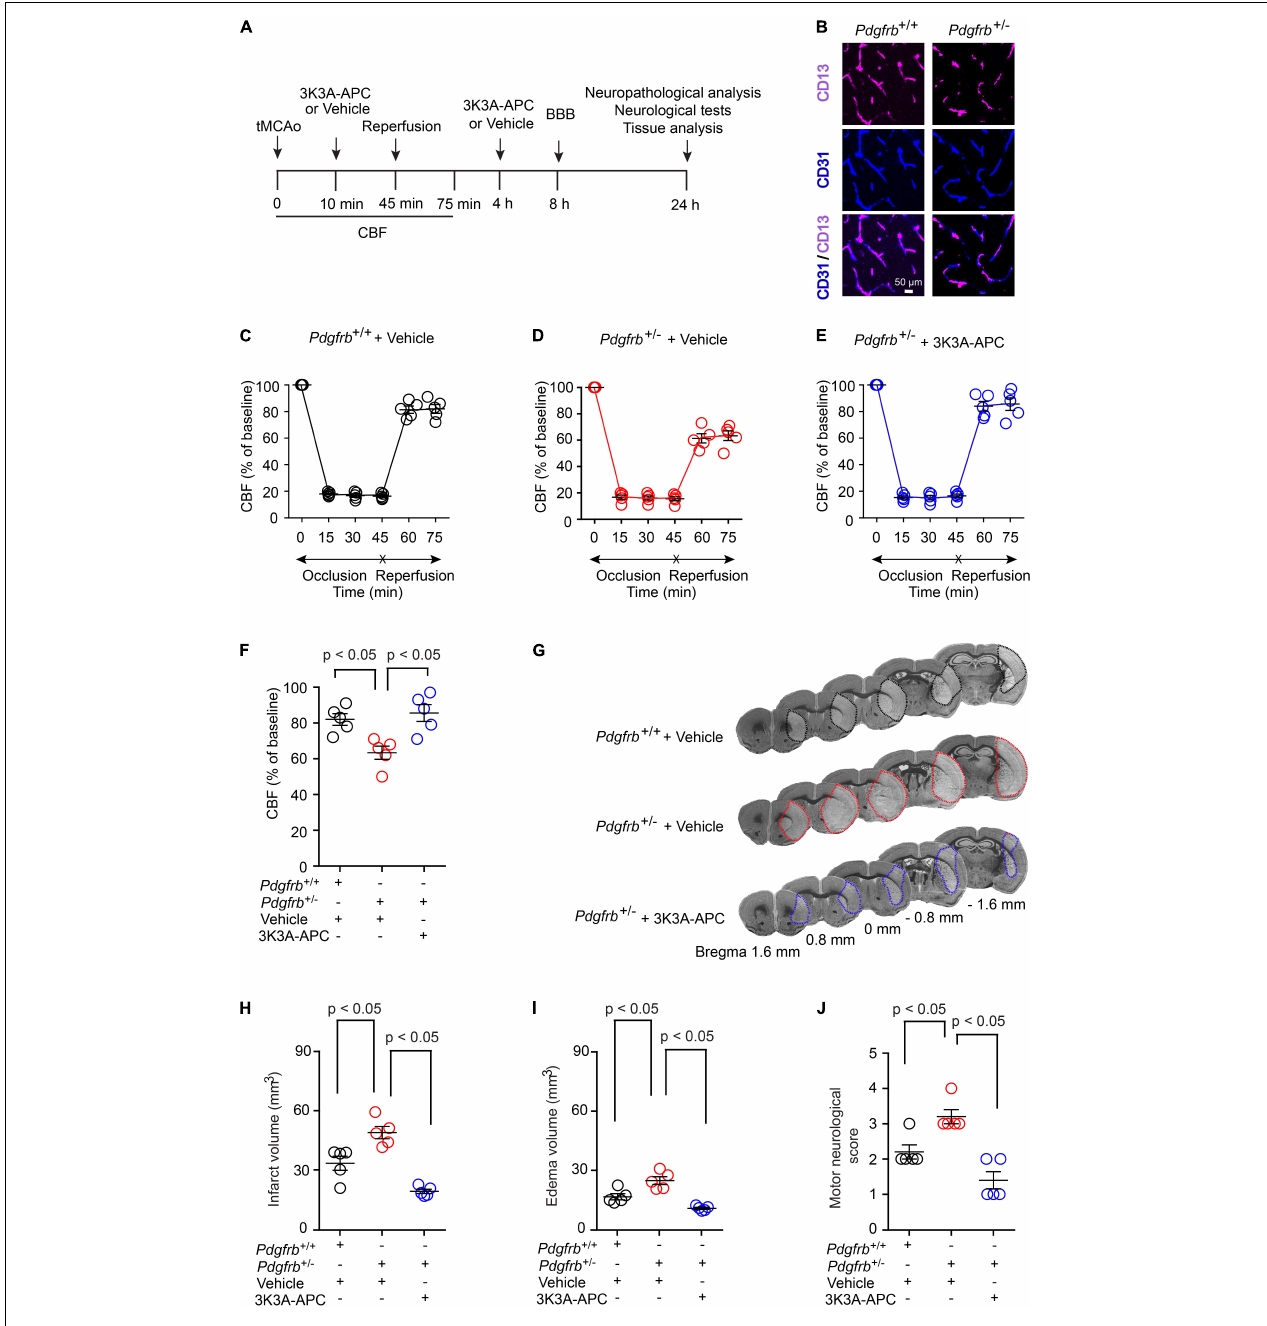
FIGURE 1 | Accelerated ischemic brain injury in pericyte-deficient Pdgfrb + / − mice and protection by 3K3A-APC. (A) Scheme of the experimental set-up. Mice underwent 45-min transient middle cerebral artery occlusion (tMCAo) followed by reperfusion. 3K3A-APC (0.2 mg/kg i.v.) or vehicle were administered 10 min and 4 h after tMCAo. Cerebral blood flow (CBF) was monitored for the first 75 min. Blood-brain barrier (BBB) breakdown was evaluated by tissue analysis 8 h after tMCAo. Motor neurological score, neuropathological, and other tissue analyses (i.e., pericyte coverage, capillary length, neurodegeneration) were performed 24 h after tMCAo. (B) Immunostaining for endothelial (CD31) and pericyte (CD13) markers in non-ischemic cortex of Pdgfrb + / + control mice and Pdgfrb + / − pericyte-deficient mice. (C–F) CBF determined by laser Doppler flowmetry during first 75 min of tMCAo in Pdgfrb + / + controls (C) and Pdgfrb + / − mice treated with vehicle (D) or 3K3A-APC (E) . (F) CBF quantification at 75 min after tMCAo initiation in mice studied in (C–E) . (G) Representative images of cresyl violet staining of brain sections (at + 1.6, + 0.8, 0, –0.8, or –1.6 mm from the bregma) 24 h after tMCAo from Pdgfrb + / + mice and Pdgfrb + / − mice treated with vehicle or 3K3A-APC. Infarct areas are outlined. Volumes of infarct (H) and edema (I) , and motor neurological score (J) 24 h after tMCAo in Pdgfrb + / + mice and Pdgfrb + / − mice treated with vehicle